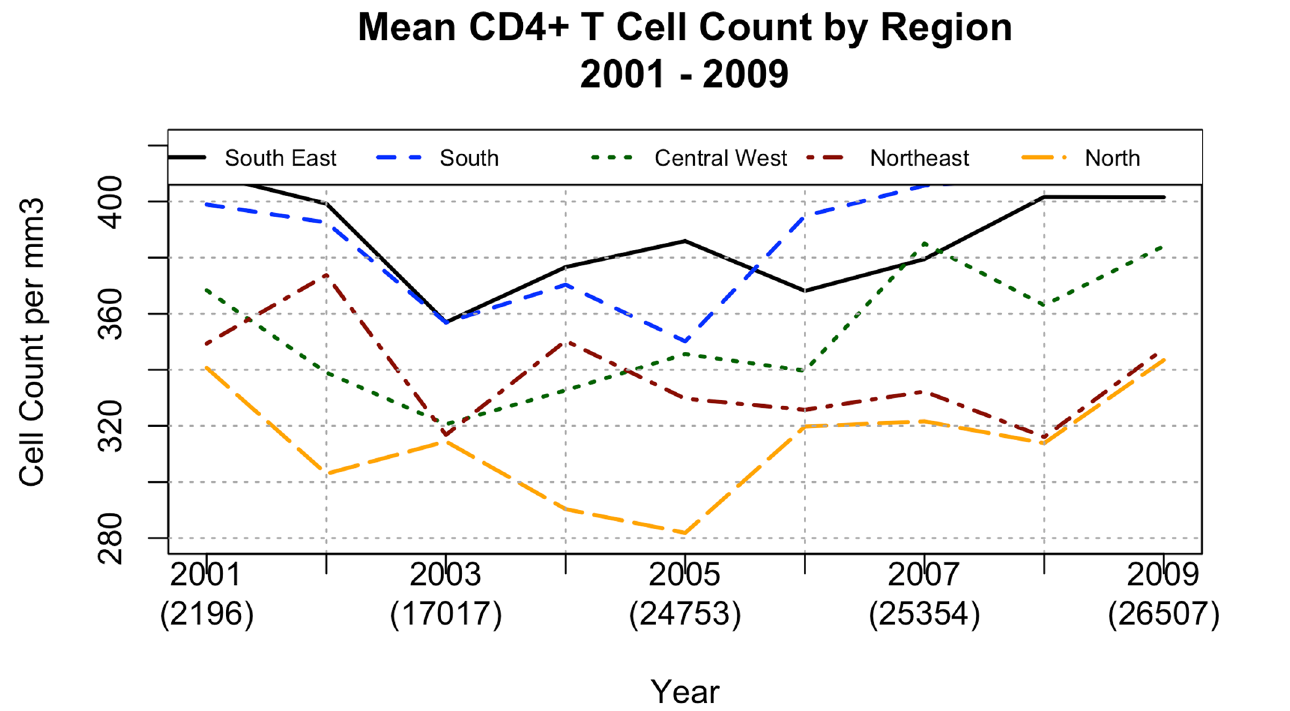
Fig 4. CD4 cell counts by region. Mean CD4+ T cell counts by region according to the first measurement for each patient from 2001 to